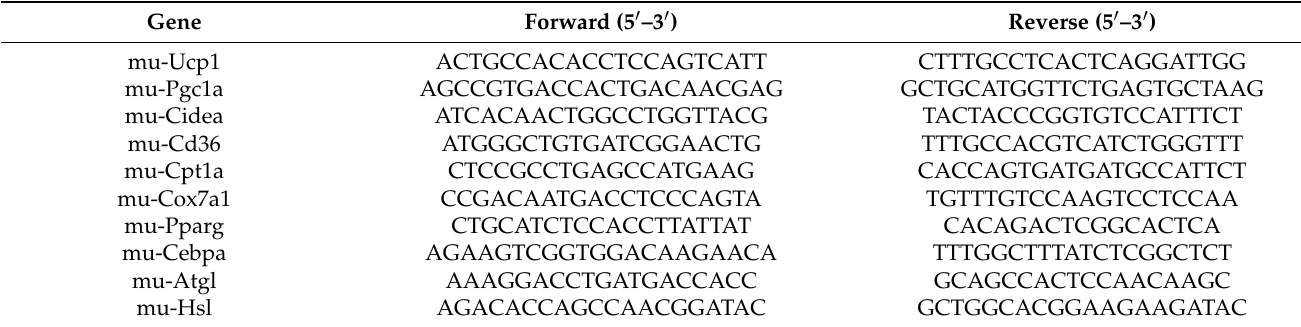
Table 1. Primer sequences for quantitative real-time